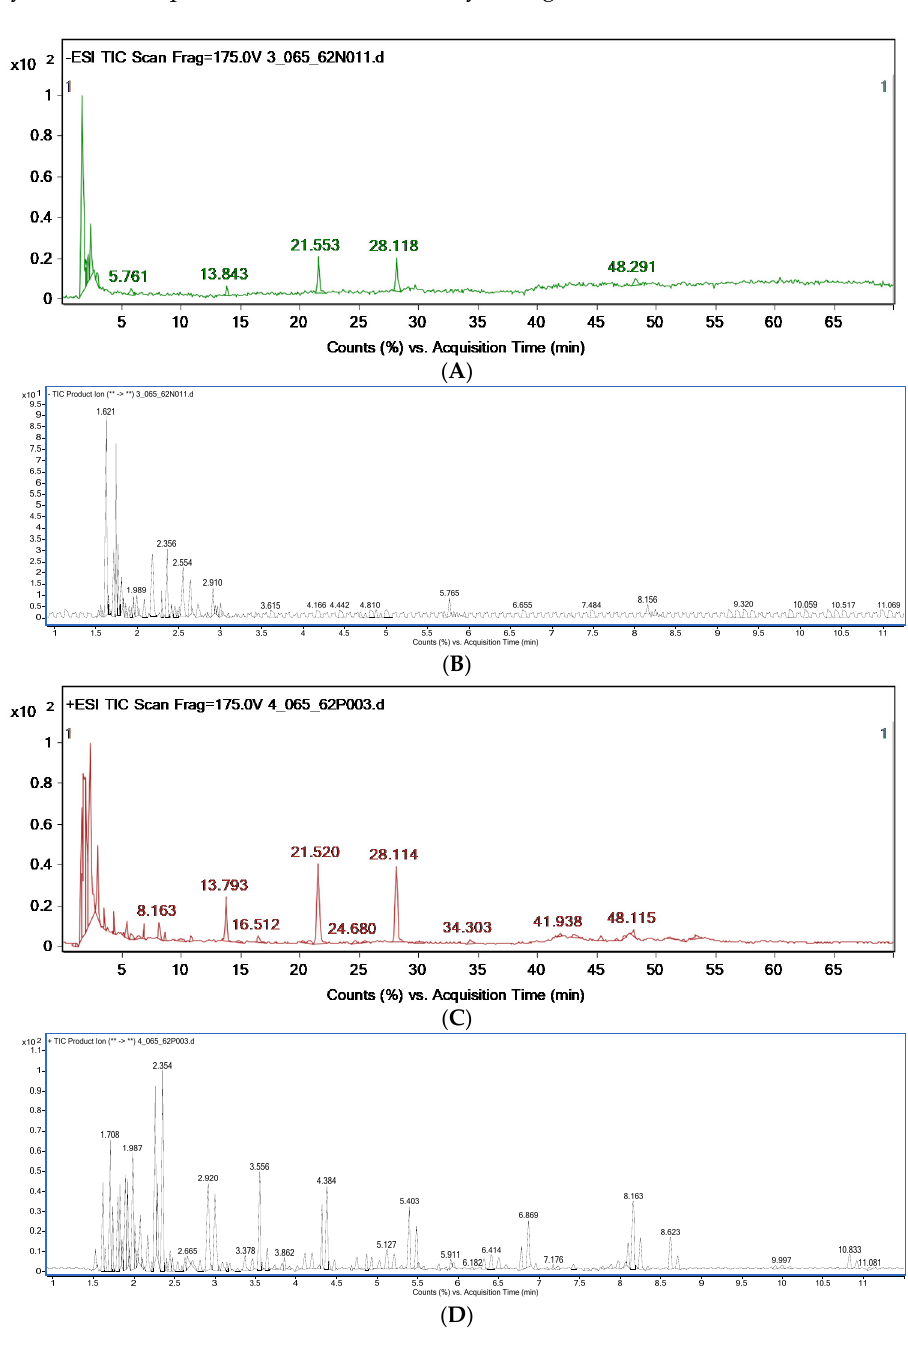
Figure 3. LC-ESI-MS/MS ( A ) and the expanded chromatogram created by plotting the total ion current in a series of product ions recorded as a function of the retention time of LC-ESI-MS/MS ( B ). LC+ESI-MS/MS ( C ) chromatograms of the D. kaki water extract and the expanded chromatogram created by plotting the total ion current in a series of product ions recorded as a function of the retention time of LC+ESI-MS/MS ( D ).